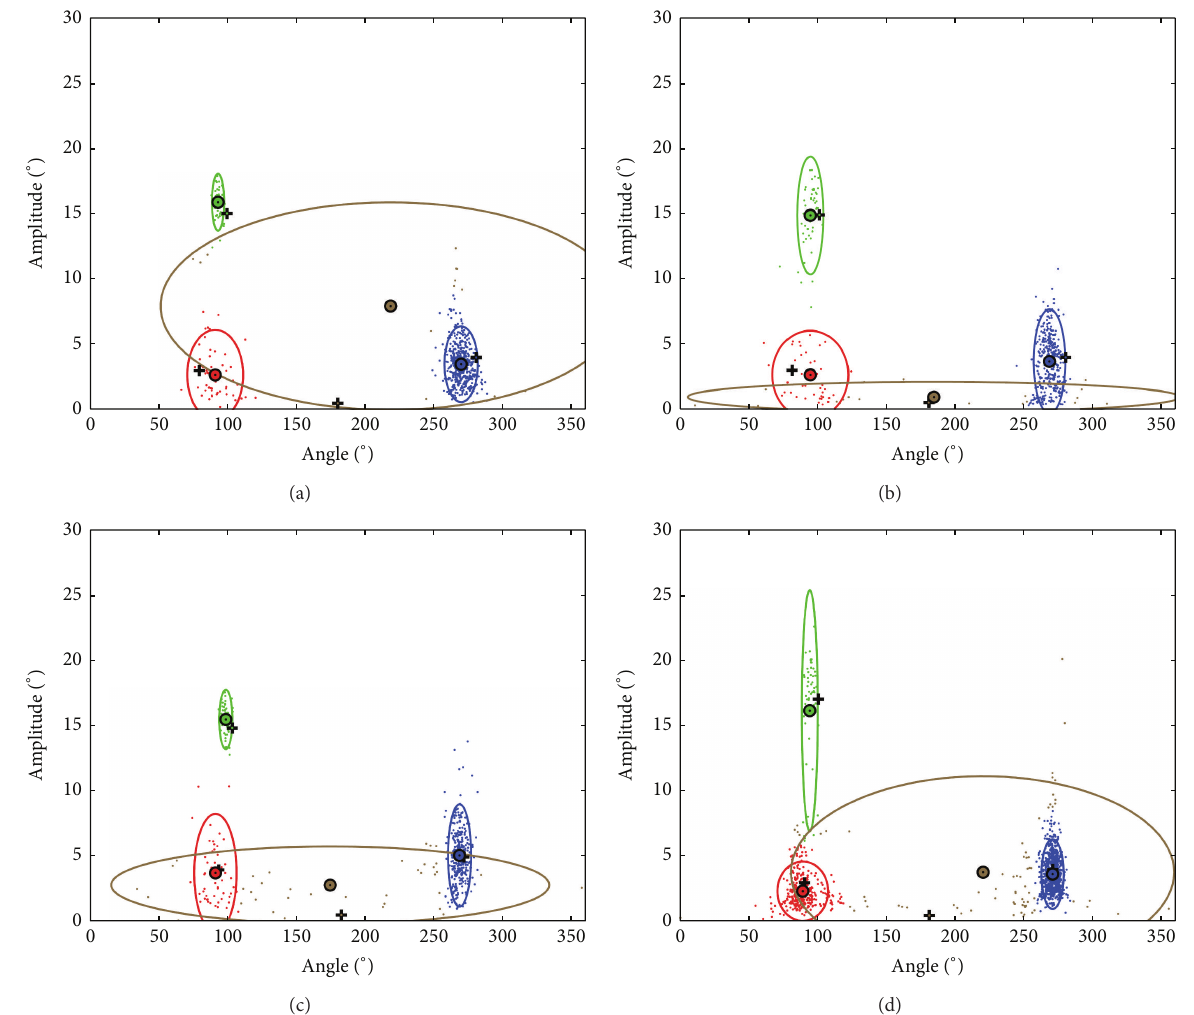
Figure 2: Scatterplots showing the amplitude and angle of saccades made across the 50 sentences for four examples of patients reading with the better eye. This data is used by the GMM to detect the four clusters within the data that represent the type of saccades made by the patients. The types of saccade are represented by the colours green (line change saccade), red (regression), blue (forward saccades), and brown (unknown). The black cross represents the start point for the GMM for each of the four clusters. The small circle represents the centre of the cluster and the surrounding larger ellipse represents a distribution of the data (calculated to be 2 standard deviations) captured by that cluster following the GMM process. Examples of outcomes from the GMM clustering are shown in Figure 1(c) for four different